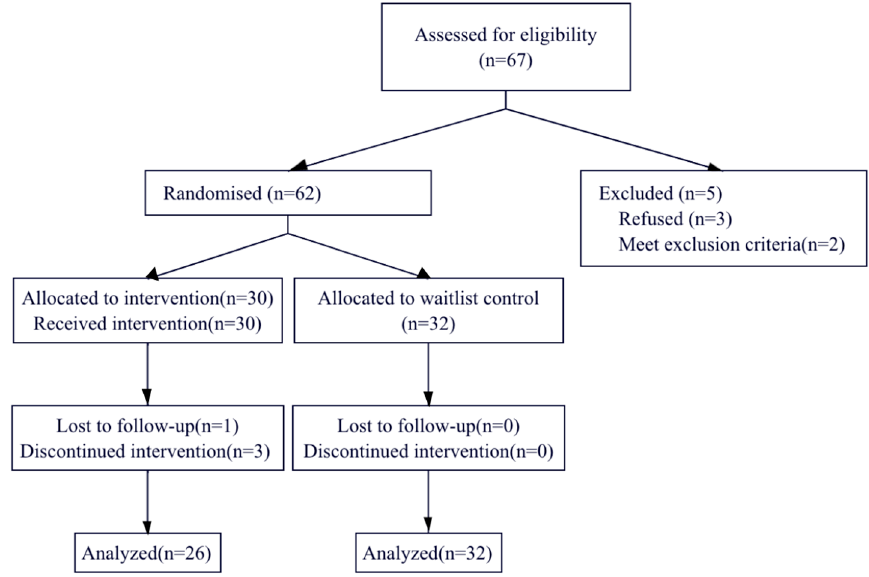
Figure 1. Participant flowchart.